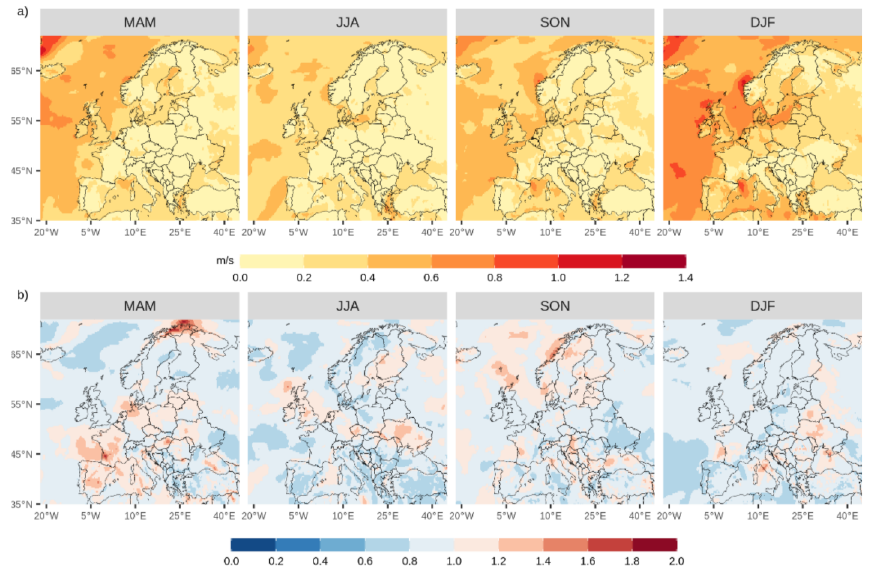
Figure 10. Spatial distribution of ( a ) MAE and ( b ) SPR for calibrated ECMWF SEAS5 ensemble seasonal forecasts of 10-m wind speed (one-month lead time) over Europe with respect to ERA5 reanalysis over